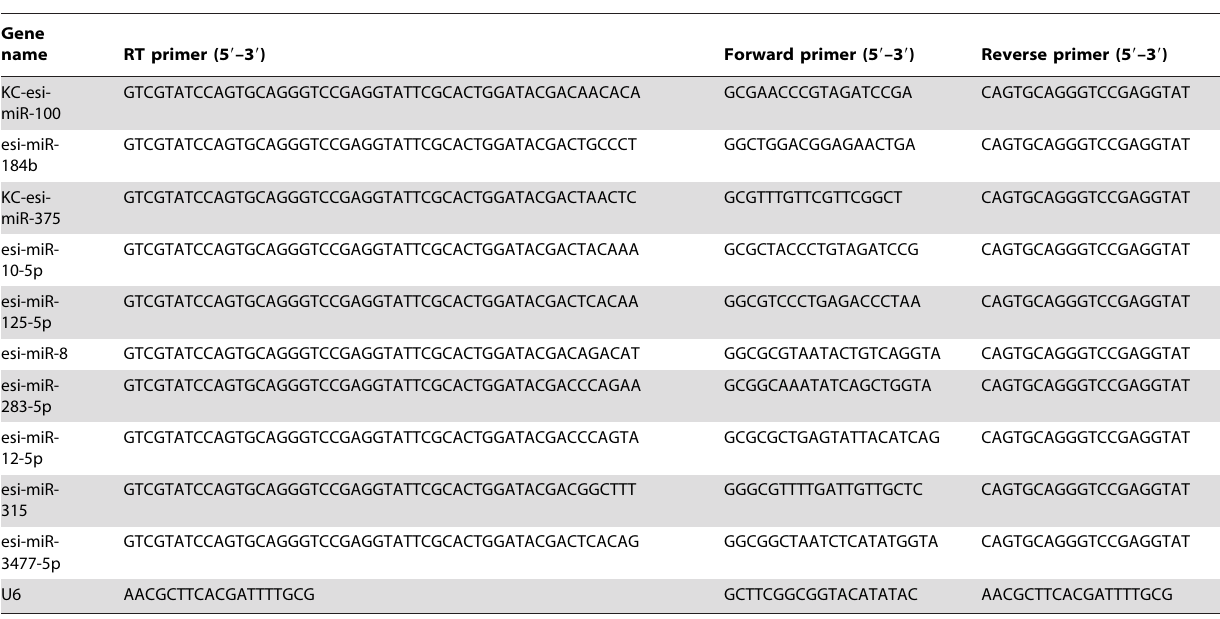
Table 1. Primers used in this study for Quantitative real-time